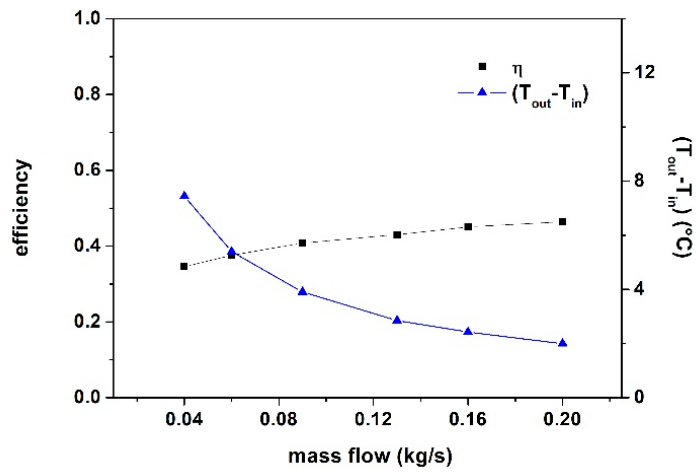
Figure 10. Results of the parametric study. Efficiency and temperature difference vs. mass flow rate.